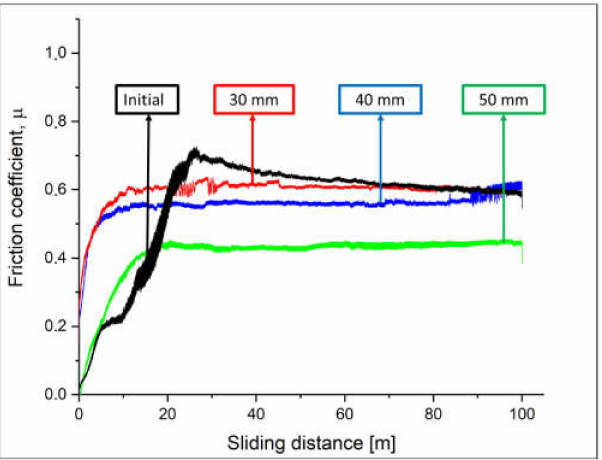
Figure 9. Results of tribological tests of Ti–Si–C coatings before (initial) and after pulsed-plasma treatment.